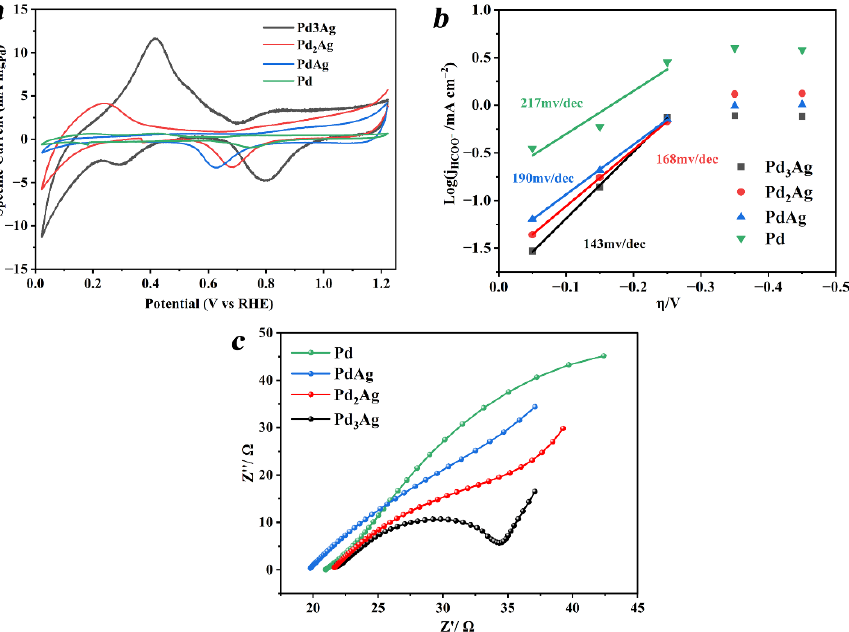
Figure 4. ( a ) ECSAs observed in N 2 -saturated 1 M KOH, ( b ) Tafel plot, and ( c ) electrochemical im- pedance spectra (EIS) in CO 2 -saturated 0.1 M KHCO 3 of Pd 3 Ag, Pd 2 Ag, PdAg, and Pd alloy catalysts.